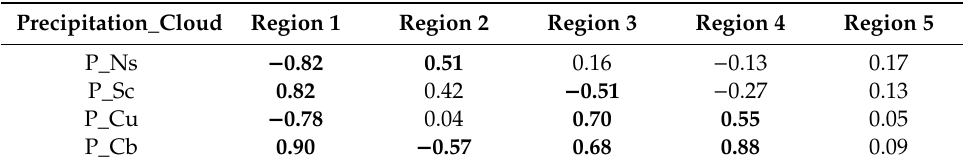
Table 2. Correlation coefficient between the diurnal cycle of precipitation and the occurrence frequency of clouds in summer.